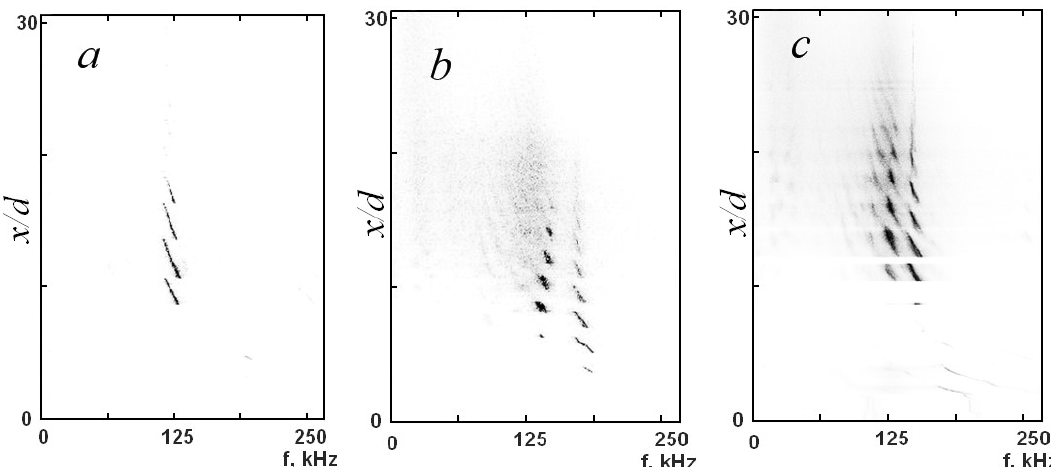
Figure 12. Spectra of acoustic oscillations generated by the underexpanded air jet in the plane of the normalized distance from the nozzle versus frequency for n = 1.75 ( a ), 2.5 ( b ), and 3 ( c ) for d = 0.72 mm and D = 0.4 mm.